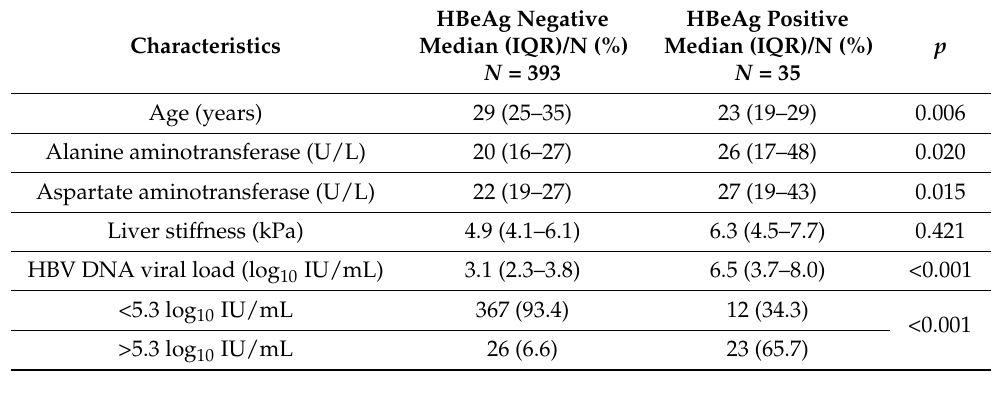
Table 1. Baseline characteristics of women of childbearing age with chronic hepatitis B virus infection in Addis Ababa, Ethiopia.